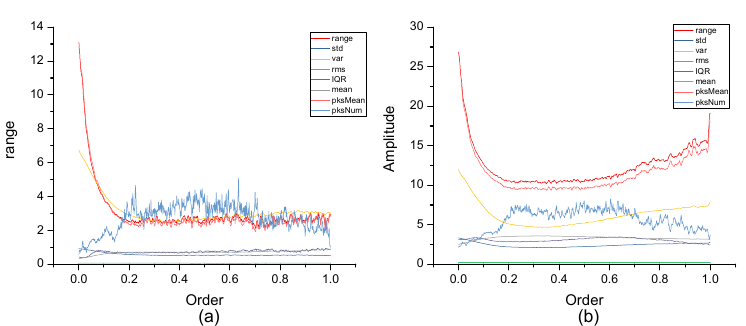
Figure 7. Standard deviation and mean of eight features of the upstairs action. ( a ) The standard deviation of each feature, ( b ) The mean of each feature. Table 3. Mean and min of standard deviation of each feature of upstairs.